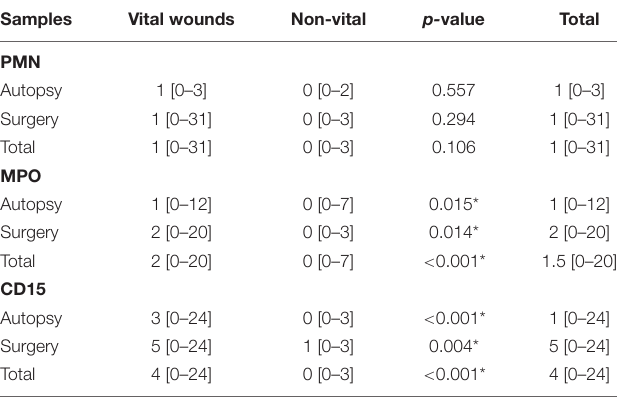
TABLE 1 | Evaluation of the median number of polymorphonuclears neutrophils (PMN) on standard histology and results of anti- myeloperoxydase (MPO) and CD15 immunohistochemistry, in the autopsy cohort and in the surgical model [median (min.-max.); * statistically significant, p < 0.05; Mann-Whitney Wilcoxon